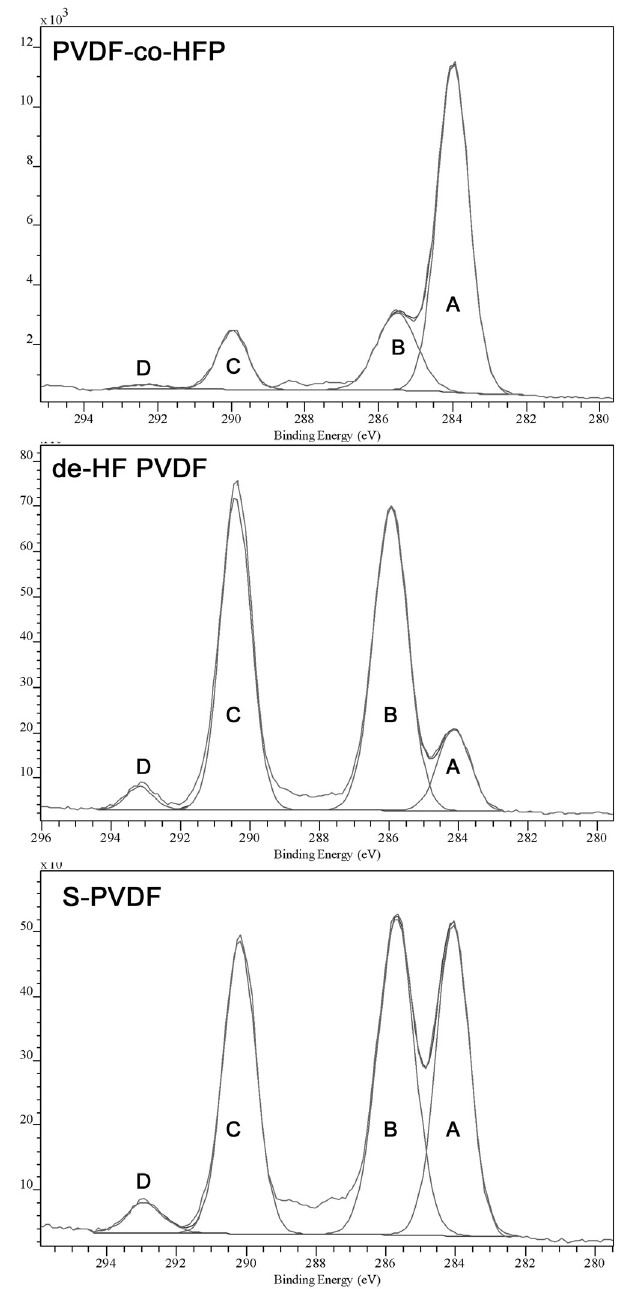
Figure 5. High resolution XPS C1s spectrum of PVDF-co-HFP, dehydrofluorinated PVDF-co-HFP, and